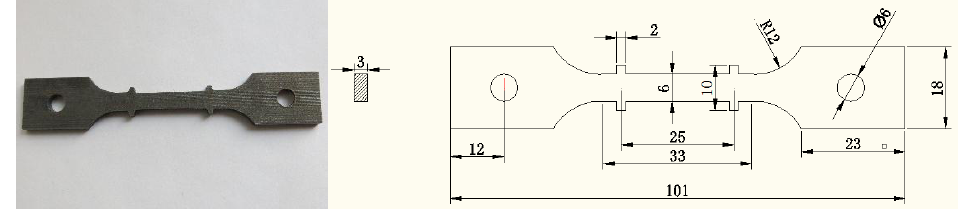
Figure 1. Specimen for quasi-static tensile test (unit: mm).